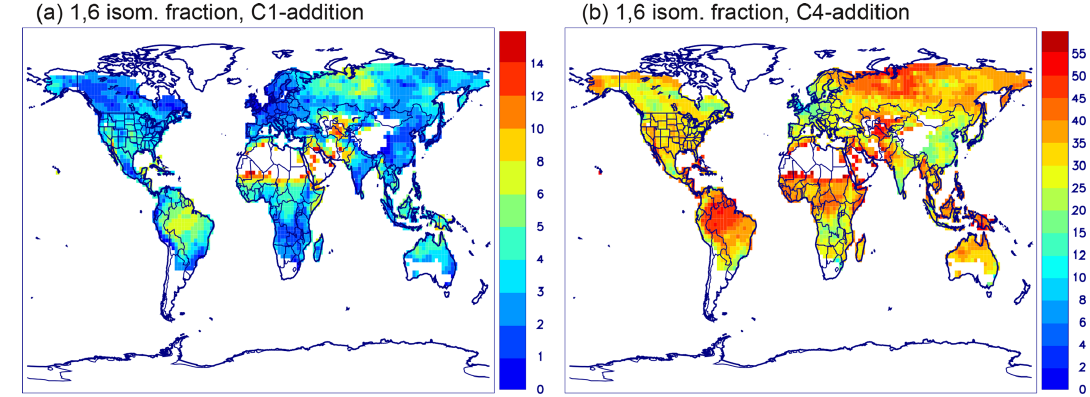
Figure 6. Calculated percentage contribution of Z - δ -hydroxyperoxy 1,6 H-shift to the overall sink of the pool of peroxys resulting from addition of OH (a) to C 1 , and (b) to C 4 of isoprene (column average, July 2013). Note the different colour scales in panels (a) and (b) .